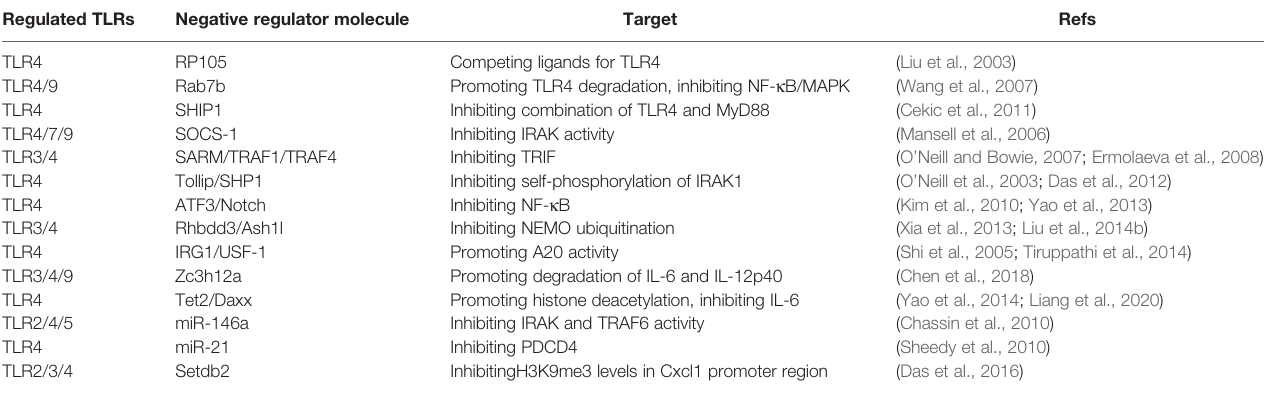
TABLE 1 | The negative regulatory molecules and targets of TLR4 signaling. Regulated